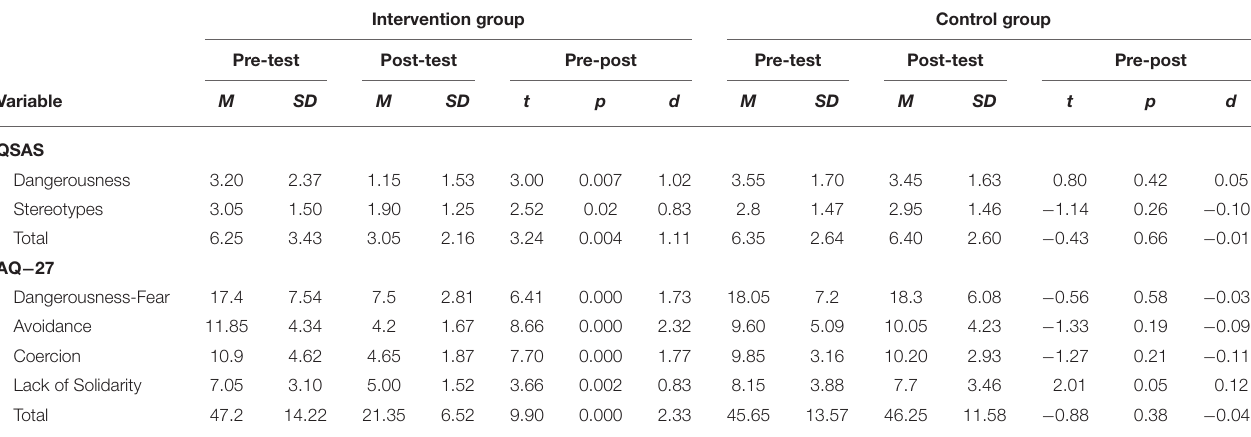
TABLE 2 | Means and standard deviations of pre-test, post-test, and Student’s t -test for related samples of post-test–pre-test differences in the study variables for the intervention group and control group. Intervention group Control group Pre-test Post-test Pre-post Pre-test Post-test Pre-post